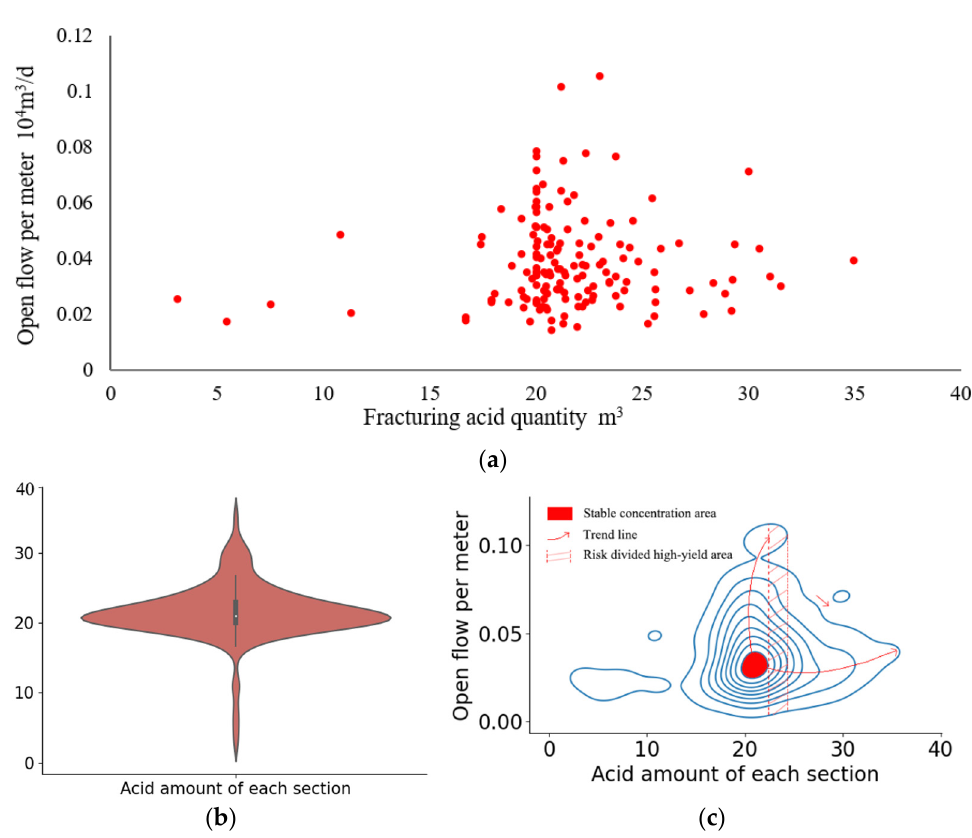
Figure 4. Analysis of acid quantity data. ( a ) Scatter plot of acid content; ( b ) violin plot of acid content; ( c ) binary KDE plot of acid quantity.